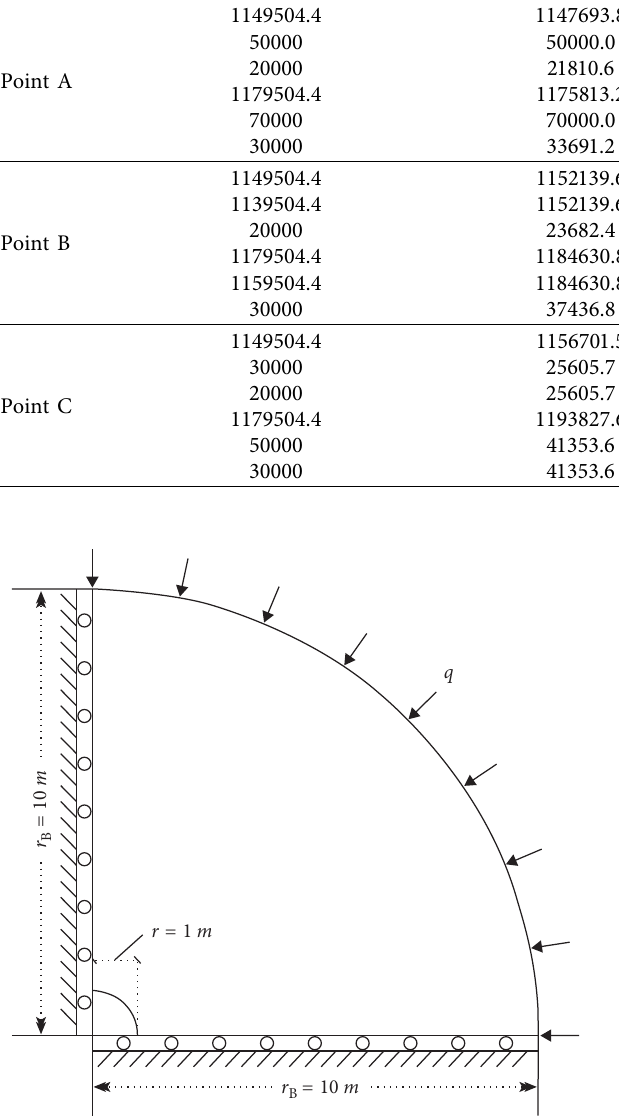
Figure 4: Example of the element mesh with 2,025